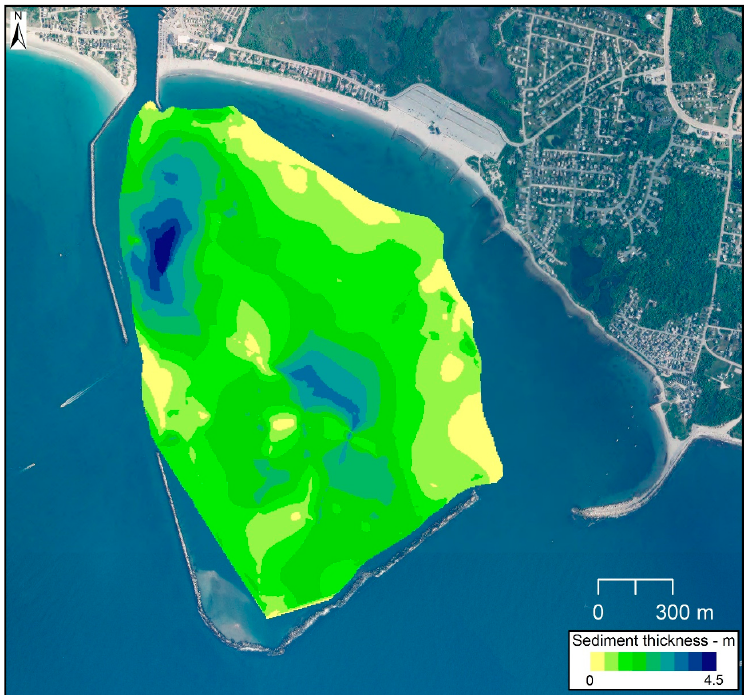
Figure 7. Interpolated sediment thickness within the HoR from seismic reflection profiles. The eastern portion of the HoR and shoreface showed no resolvable sediment above the ravinement surface.